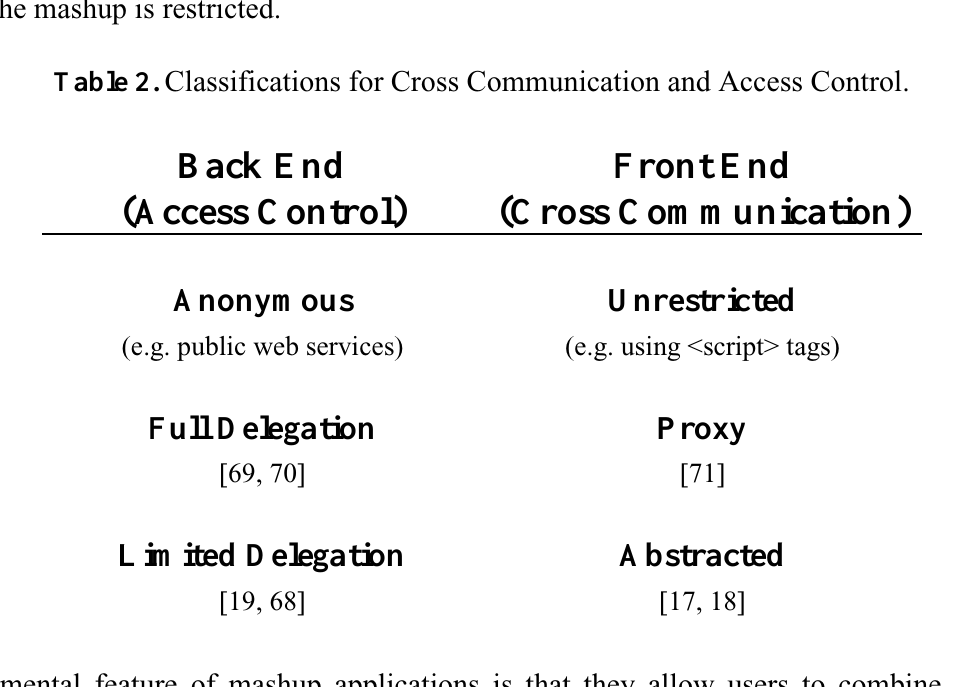
Table 2. Classifications for Cross Communication and Access